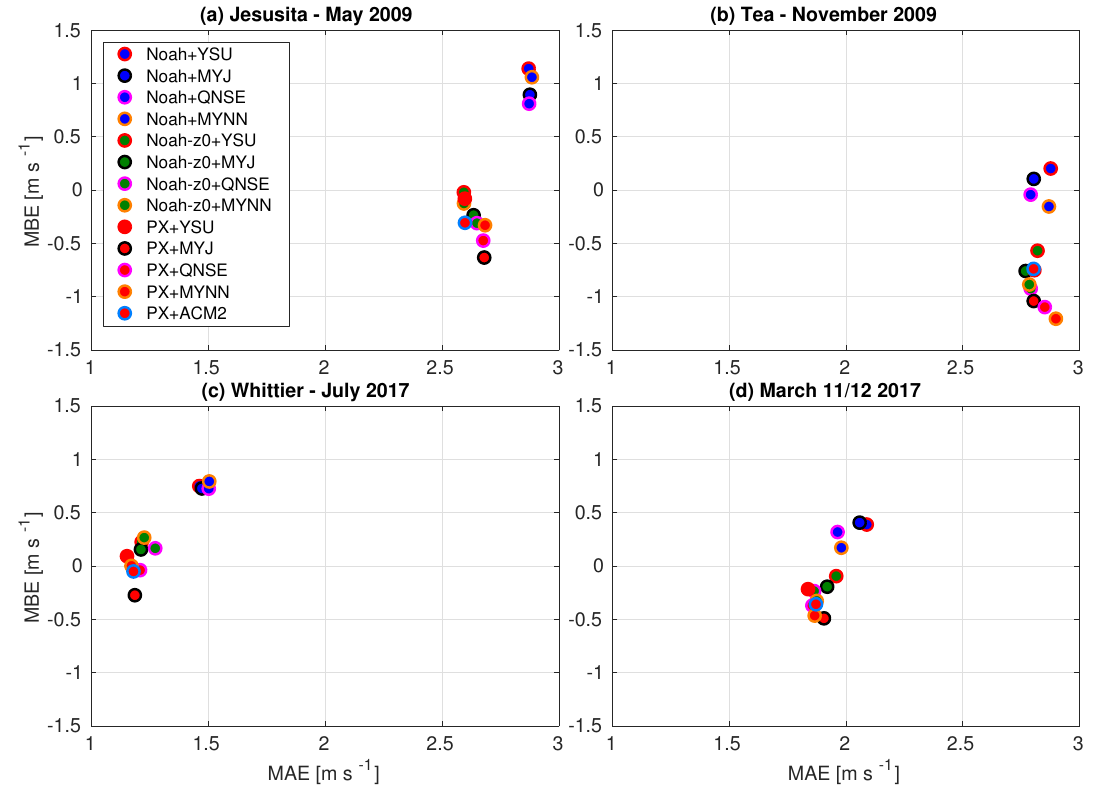
Figure 4. Scatterplot of network- and event-averaged sustained wind speed MAE vs. bias (MBE) from 13 physics ensemble members for the ( a ) Jesusita, ( b ) Tea, ( c ) Whittier, and ( d ) 11/12 March 2017 case studies. The legend in ( a ) applies on all panels. Data periods used for comparison are indicated in the text of Section